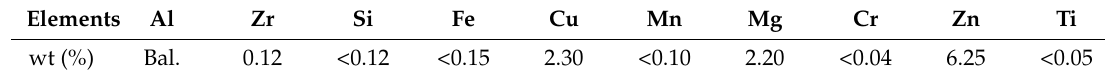
Table 1. Nominal chemical composition of AA7050 alloy (wt